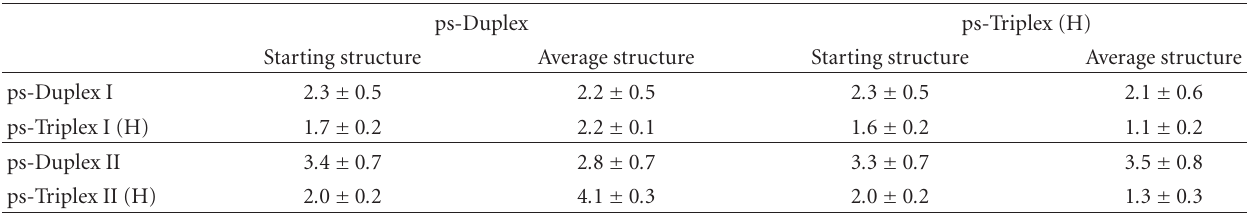
Table 5: Cross RMSd (in ˚A) between trajectories and the average structures obtained in the other trajectories. When parallel duplexes and triplexes are compared only, the Hoogsteen duplex embedded in the triplex is considered.